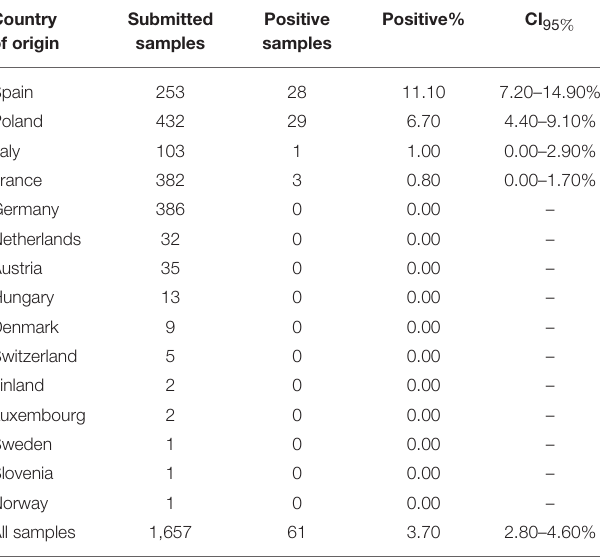
TABLE 2 | Submitted samples for Brucella spp. PCR testing: Country of origin, positivity and confidence intervals (CI 95 %